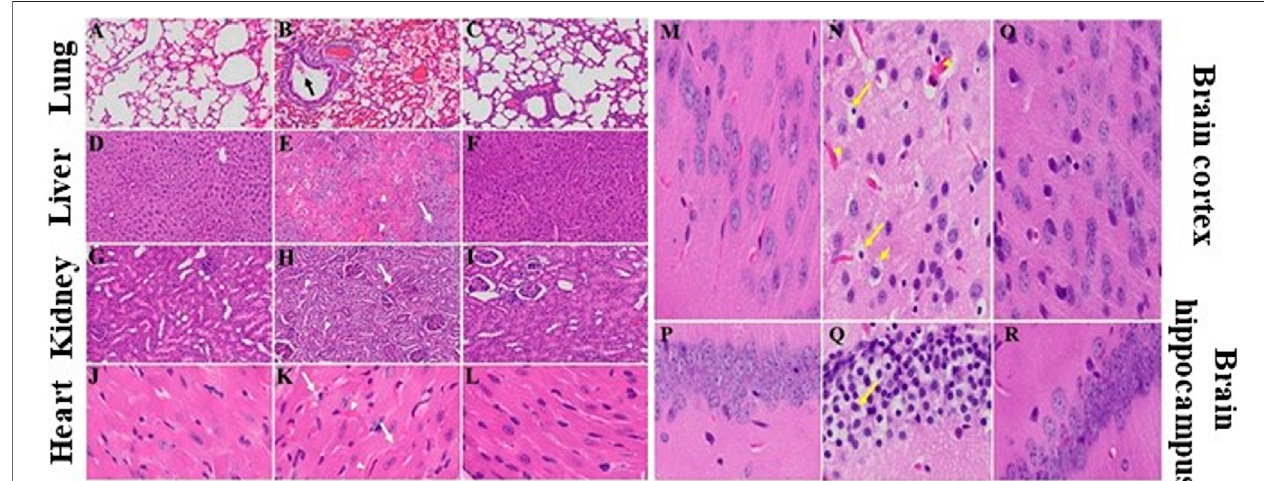
FIGURE 5 | SPIKENET (SPK) diminishes MHV-1-induced pathological changes in lung, liver, kidney, heart and brain. Representative histological images of hematoxylinandeosin(H&E)stainedlung,liver,kidney,heartandbraintissuesectionsofanormalmouse (A,D,G,J,M,P) andaninfectedmouseatday7 (B,E,H,K,N,Q) . “ MHV-1-infected mice lungs showed arterial endothelial swelling, in fl ammation/granular degeneration of cells and migration of leukocytes into lung (arrow). Peribronchiolar interstitial in fi ltration, bronchiole epithelial cell necrosis and necrotic cell debris within alveolar lumens, alveolar exudation, in fi ltration, hyaline membraneformationandalveolarhemorrhagewithredbloodcellswithinthealveolarspaceandinterstitialedemawerealsoobservedinMHV-1-infectedmice (B) .MHV- 1-infected mice at day 7 showed hepatocyte degeneration, severe periportal hepatocellular necrosis with pyknotic nuclei, severe hepatic congestion (arrowheads), ballooned hepatocytes (arrow), vacuolation and the presence of piecemeal necrosis, as well as hemorrhagic changes and hemorrhagic changes when compared to uninfected mice (E) . Kidney from an MHV-1 infected mouse showed proximal and distal tubular necrosis (arrowheads), hemorrhage in the interstitial tissue (arrow), and vacuolation of renal tubules (H) . MHV-1 infected mouse heart showed severe interstitial edema (arrows), vascular congestion and dilation (arrowheads), and red blood cell extravasation into the interstitium (K) . Congested blood vessels (arrowhead), pericellular halos (short arrow), pyknotic nuclei amid associated vacuolation of the neuropil (long arrows), perivascular cavitation suggestive of edema, vacuolation of neuropils, darkly stained nuclei, and acute eosinophilic necrosis were observed in MHV-1-treatedmice (N,Q) ,ascomparedtountreatedmice ” (Paidasetal.,2021).MHV-1inoculatedmicetreatedwith5 mg/kgSPIKENET(SPK)amelioratedallofthese changes (C,F,I,L,O,R) (H&E original magni fi cation is ×400 for all